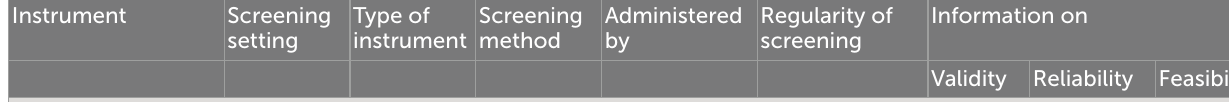
TABLE 3 Instrument characteristics in